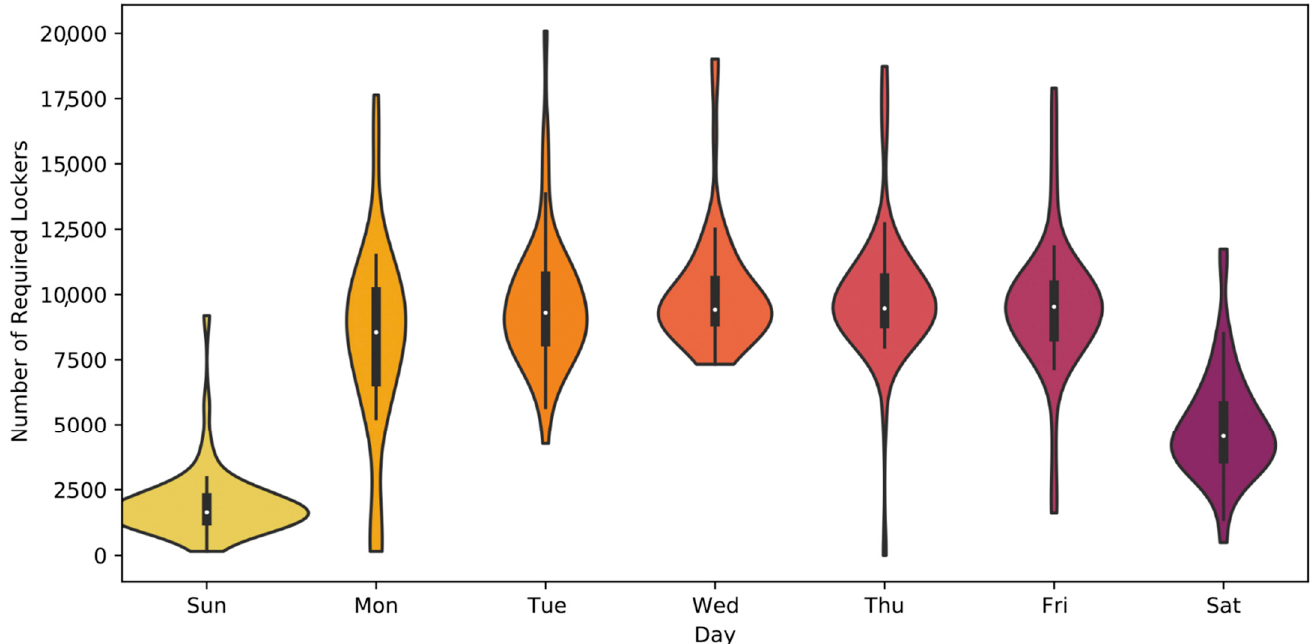
Figure 3. Number of lockers required per day depending on the day of the week (Density 1.0).